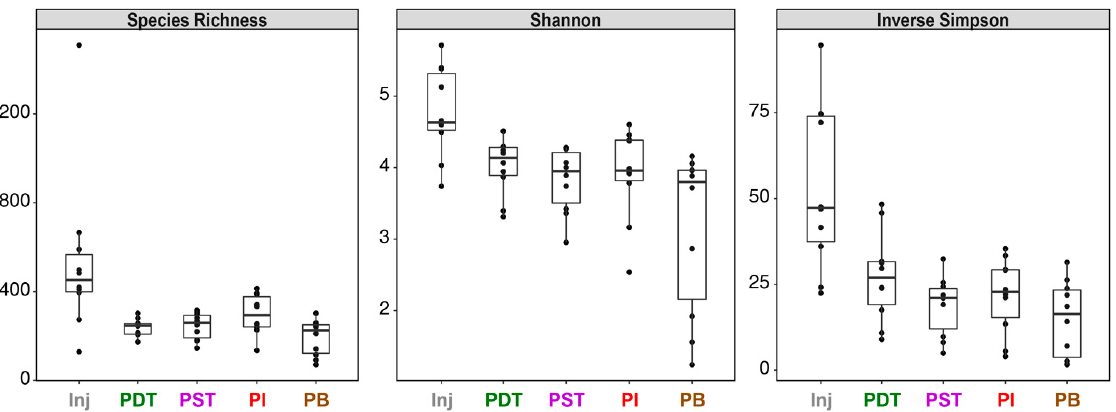
Figure 4. Alpha diversity metrics on the microbial communities in each sample. Left : species richness (i.e., the total number of unique ASVs observed in each sample); Middle : Shannon index; Right : inverse Simpson index.